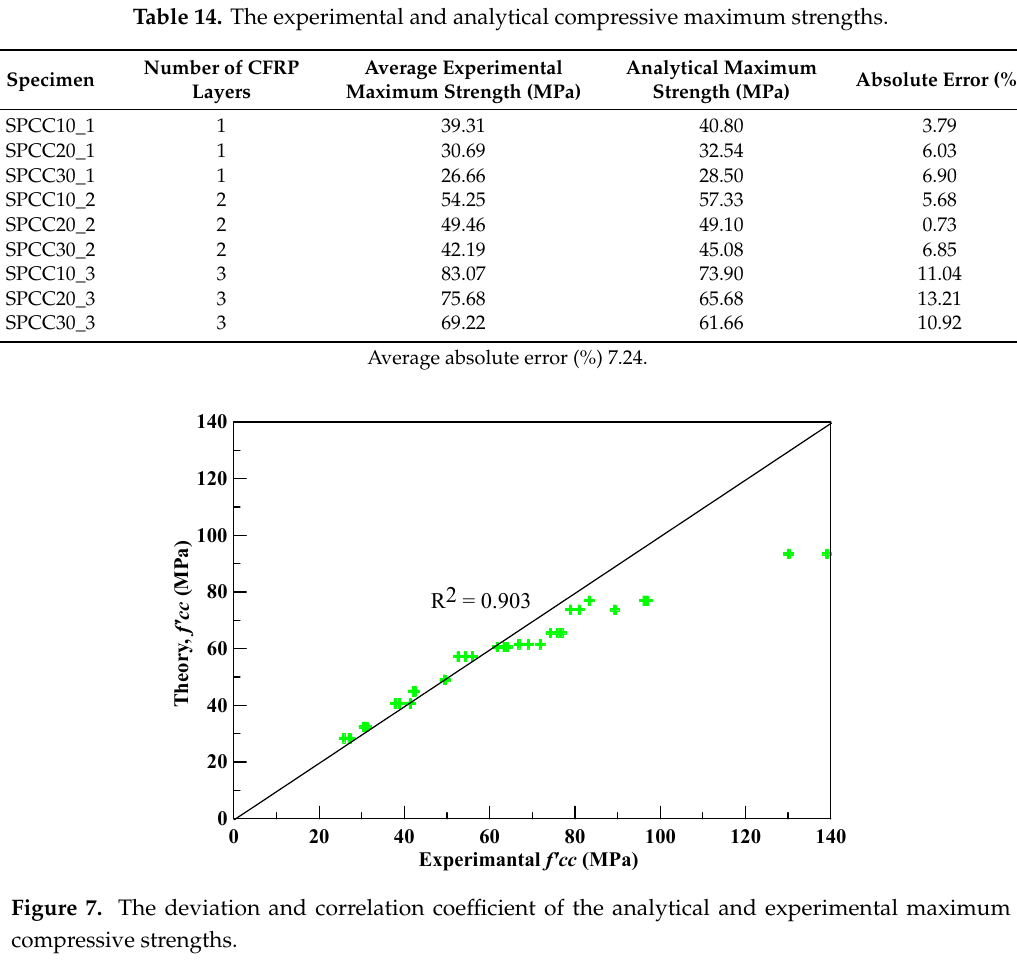
Table 14. The experimental and analytical compressive maximum strengths.